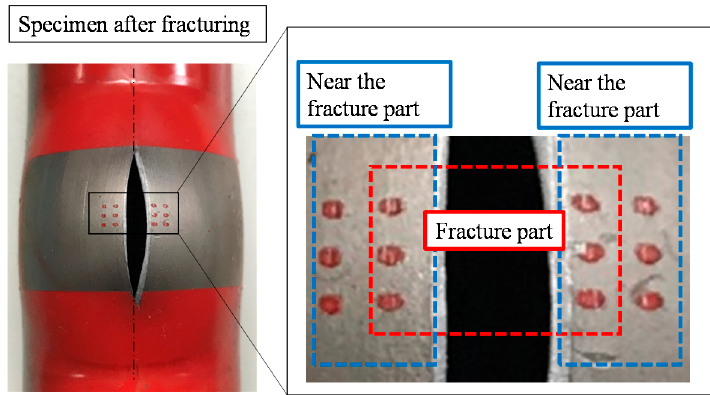
Figure 8. Appearance of measurement points on deformed tube.